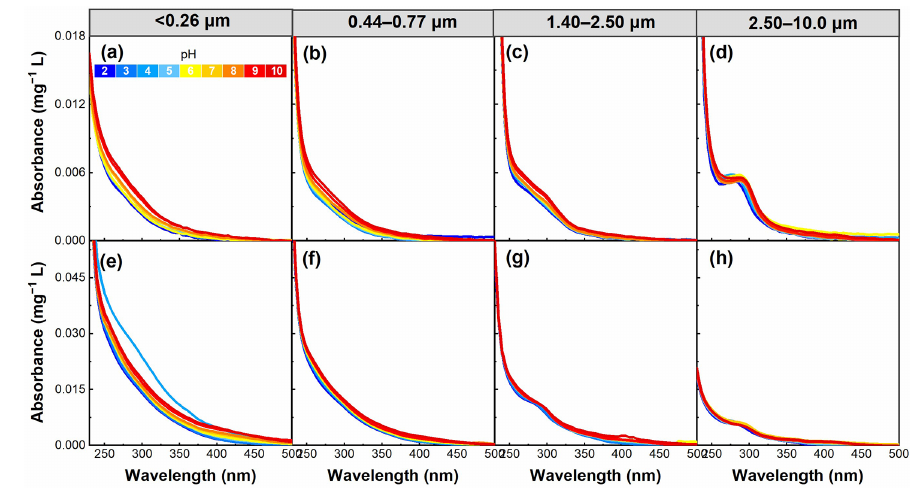
Figure 3. pH dependence of absorption per unit mass of WSOC in particles of different sizes in summer (a–d) and winter (e–h) in the pH range of 2–10.